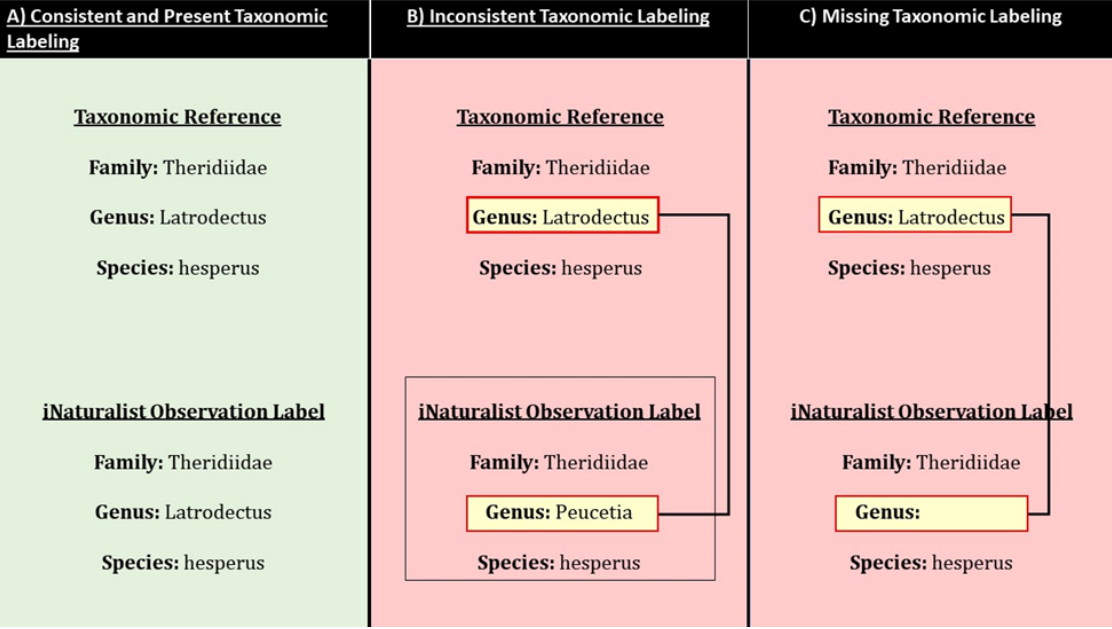
Figure 3. Taxonomic consistency workflow. Each observation could earn a maximum of